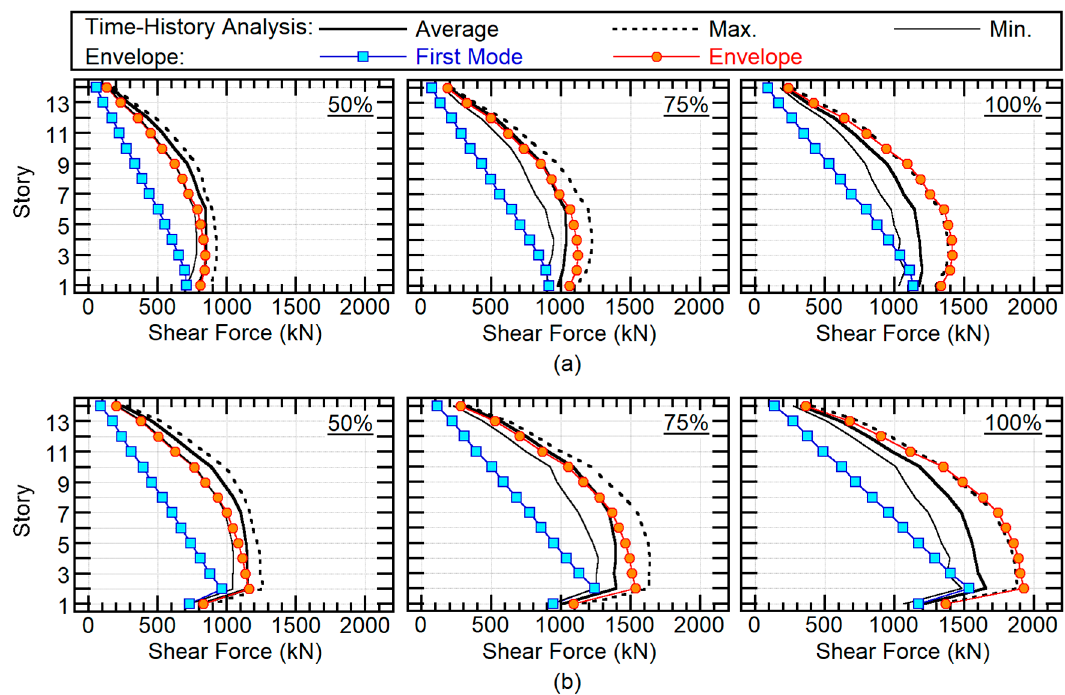
Figure 14. Comparisons between the maximum shear forces of vertical members (Art-S series): ( a ) column X 2 Y 1 and ( b ) column X 2 Y 2 (with spandrel walls).